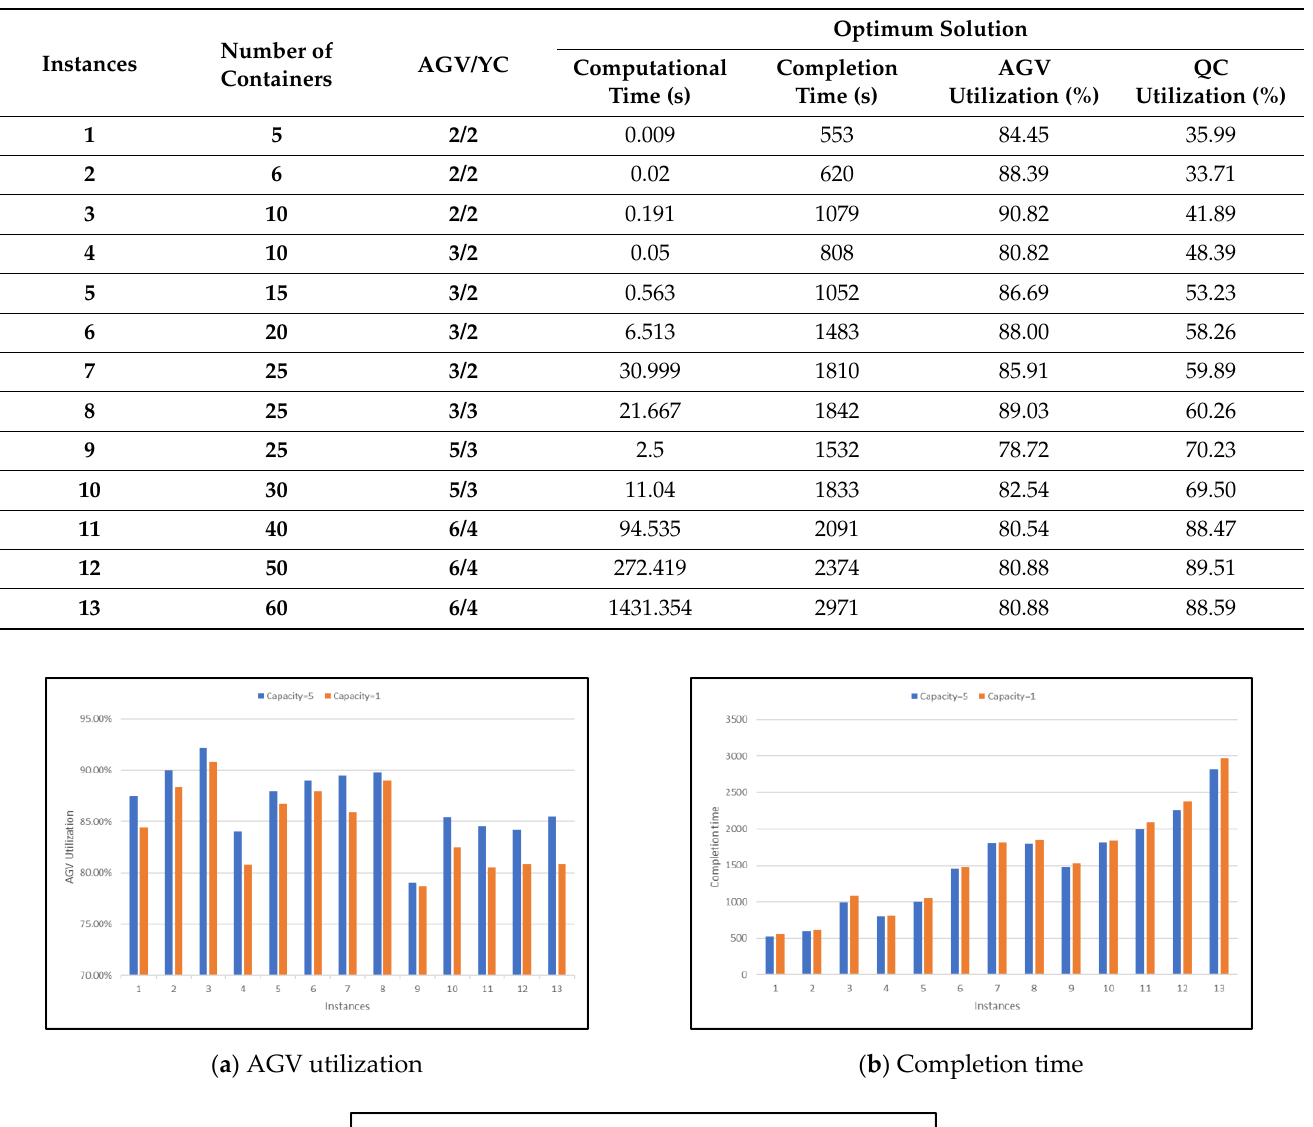
Table 2. Computational results for dual-trolley QCs with a buffer capacity equal to one.